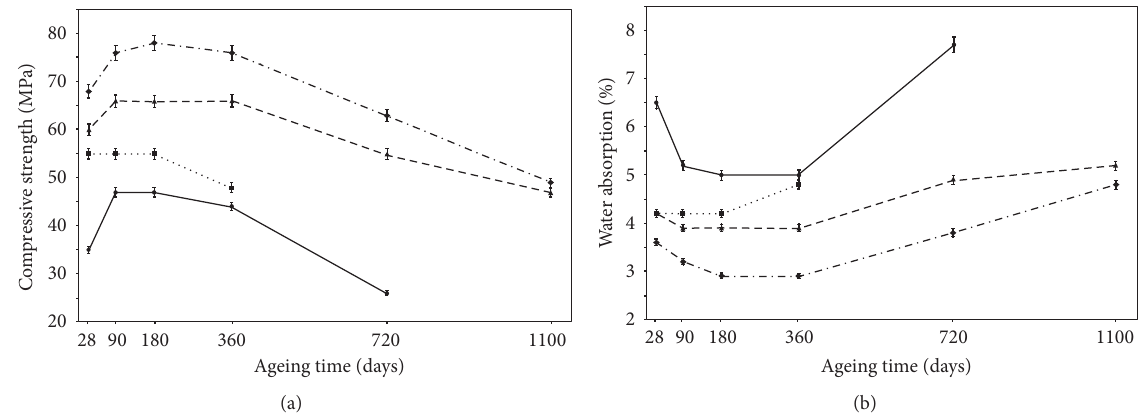
Figure 4: Trends of compressive strength (a) and water absorption (b) displayed as a function of curing time. Each composition refers to the following graphic: reference = —; chromium oxide = –– –; ultramarine = - ⋅ - ⋅ -; aluminium silicate (Na) = ⋅ ⋅ ⋅ .